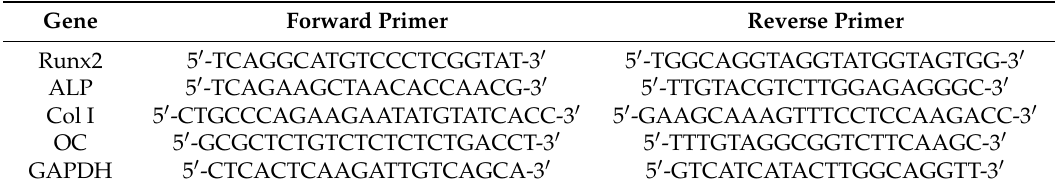
Table 1. The primer sequences used for the RT-qPCR